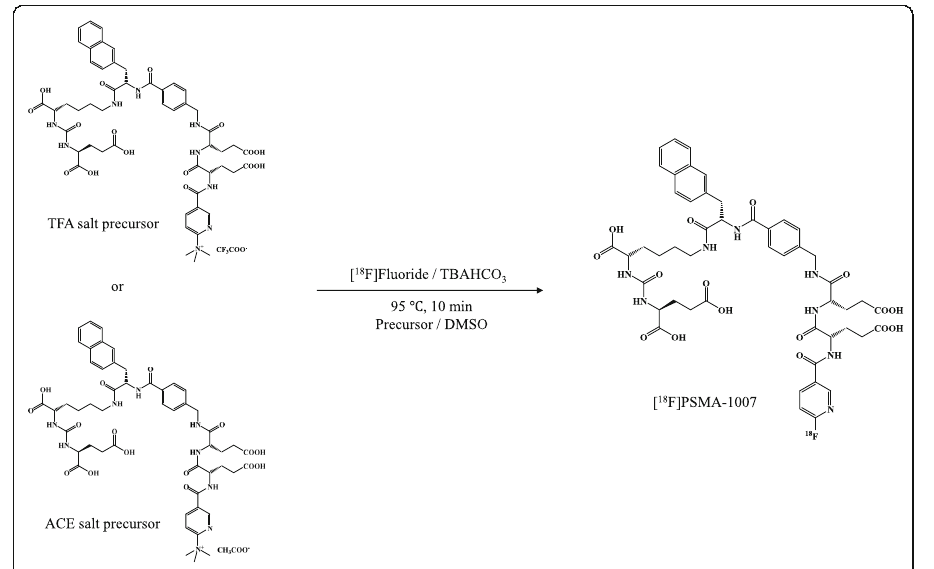
Fig. 4 Pathway of the radiosynthesis of [ 18 F]PSMA-1007. The precursor trifluoroacetic acid (TFA) salt was used at 3 mg in 2 mL of DMSO and the precursor acetic acid (ACE) salt was used at 2 mg in 2 mL of DMSO. The other conditions were the same with both